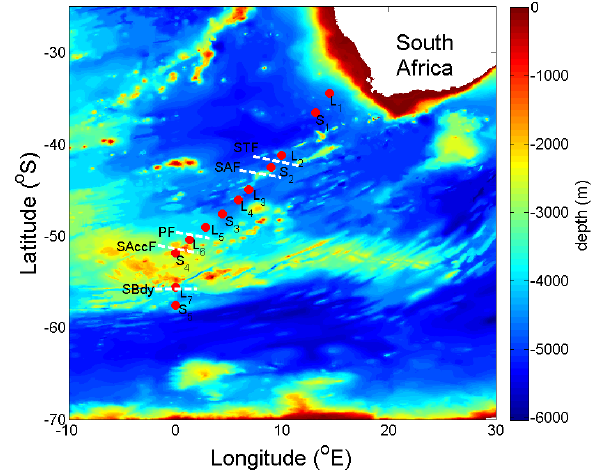
Figure 1. Cruise track during the Bonus Goodhope 2008 campaign in the Atlantic Southern Ocean. Red dots indicate the sampling positions for 15 N uptake experiments. The hydrographic fronts, Subtropical Front (STF), Sub-Antarctic Front (SAF), Polar Front (PF), South Antarctic Circumpolar Current Front (SAccF) and Southern Boundary (Sbdy) are indicated by dotted white lines.